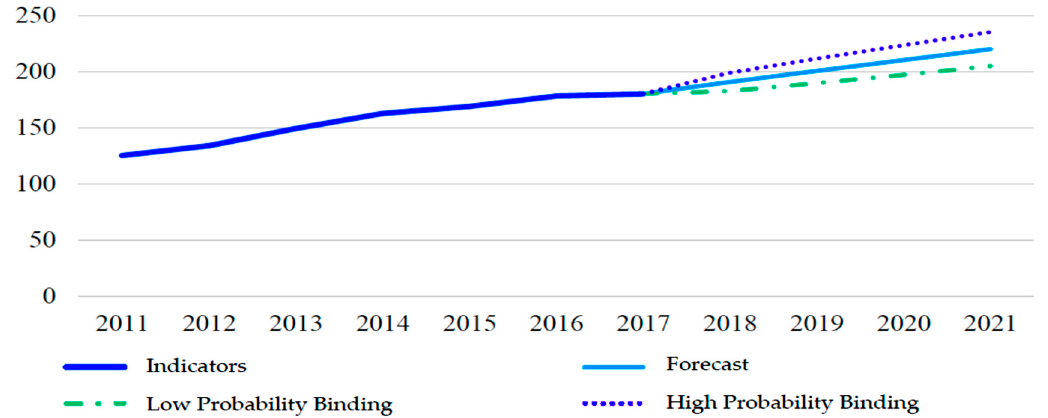
Figure 6. Forecast of revenues for the automotive industry 2018–2032, billions of dollars. Source: calc. by author by data [56].